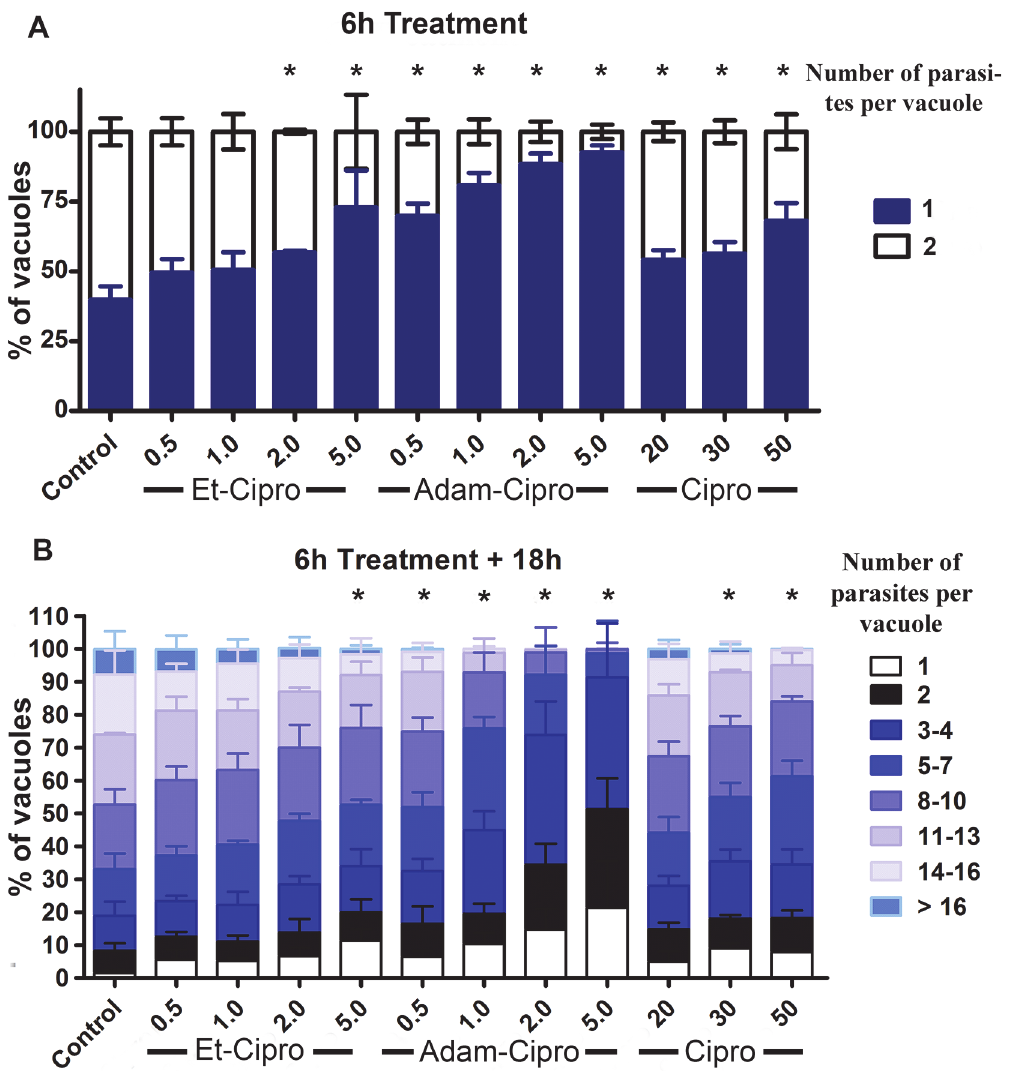
Fig 2. Early effects of ciprofloxacin (Cipro) derivatives in tachyzoite cell division inside host cells. (A) Tachyzoites of T . gondii were treated with Cipro derivatives for 6 h, from 1 – 7 h post-infection, and the number of parasites per vacuole was analyzed by light microscopy. (B) After 6 h, the medium containing drugs was removed and replaced with fresh medium without drugs. Tachyzoites were allowed to proliferate for an additional 18 h, and the number of parasites per vacuole was counted. * P < 0.05, results were analyzed by two-way ANOVA statistical test.